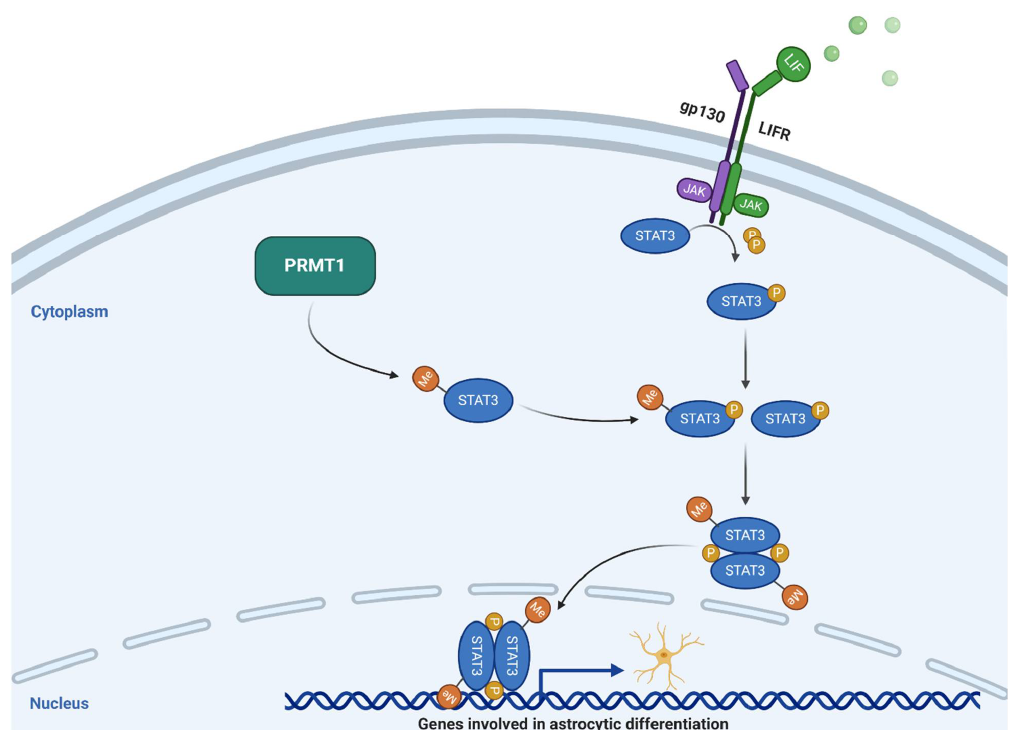
Figure 1. Schematic drawing of the PRMT1-STAT3 axis. JAK = Janus kinase; LIFR = Leukemia inhibitory factor receptor; Me = Methyl; P = Phosphorous; PRMT1 = Protein arginine methyltransferase 1; STAT3 = Signal transducer and activator of transcription 3. Adapted from “PI3K/Akt, RAS/MAPK, JAK/STAT Signaling”, by BioRender.com (2020). Retrieved from https://app.biorender.com/biorender-templates.